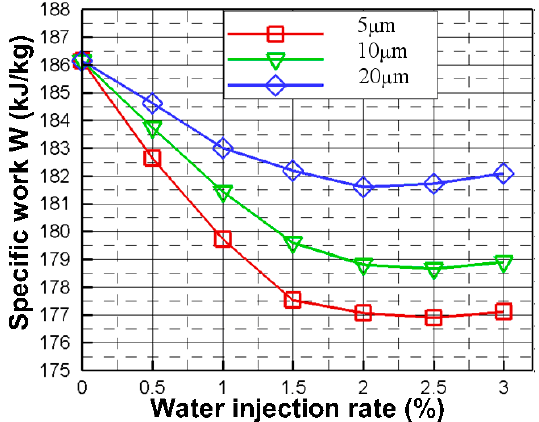
Figure 18. Comparison of specific compression work per mass under dry and water injection cases.